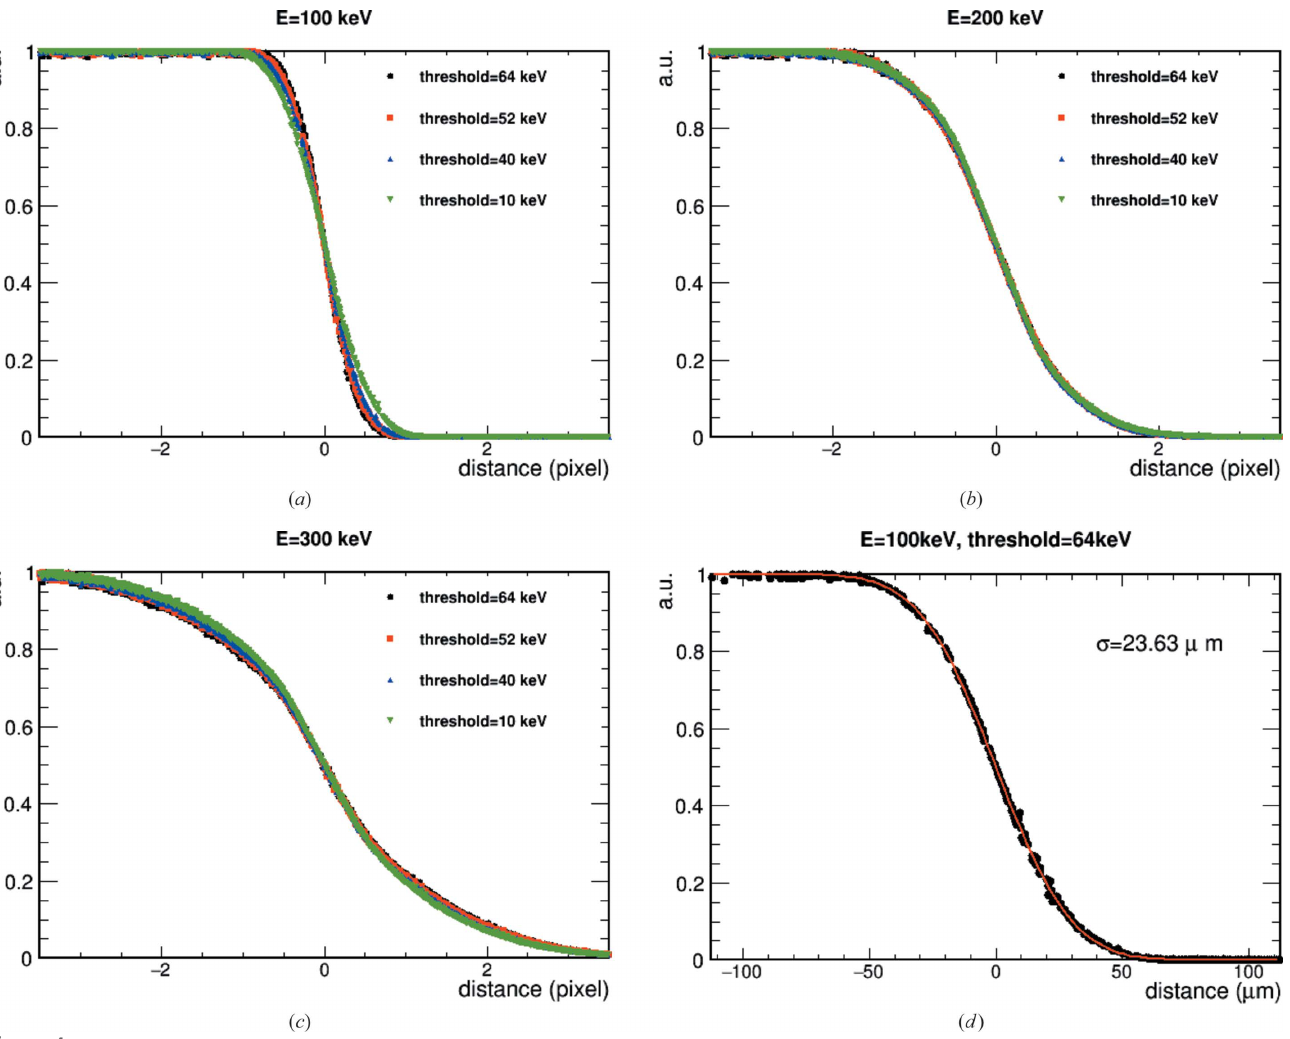
Figure 4 The edge spread function for different threshold settings for ( a ) 100, ( b ) 200 and ( c ) 300 keVelectrons. ( d ) The edge spread function and corresponding fit for the best resolution case, obtained for 100 keV electrons and threshold set at 64